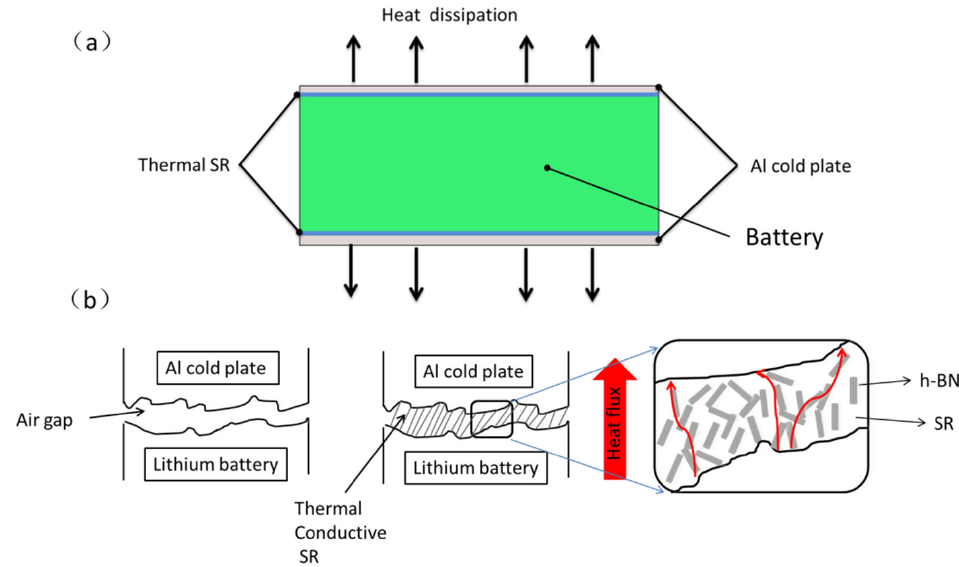
Figure 2. ( a ) Structural model of battery thermal management simulation; ( b ) interface between battery and aluminum cold plate.